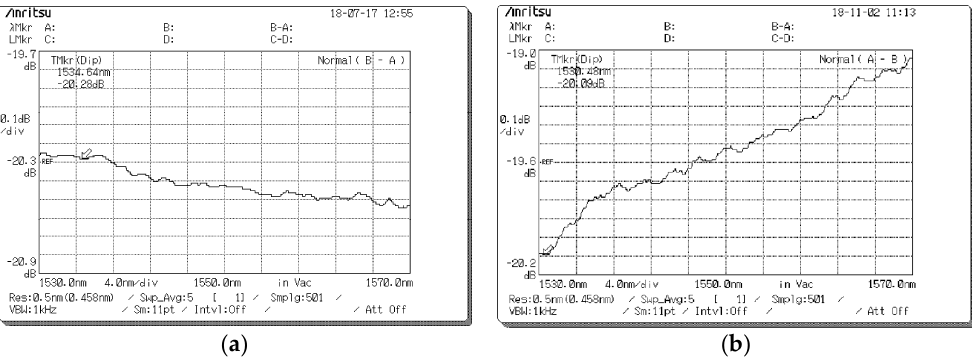
Figure 8. Measured transmission spectrum at an attenuation level of 20 dB, ( a ) the optimized MEMS VOA, ( b ) the conventional MEMS VOA.